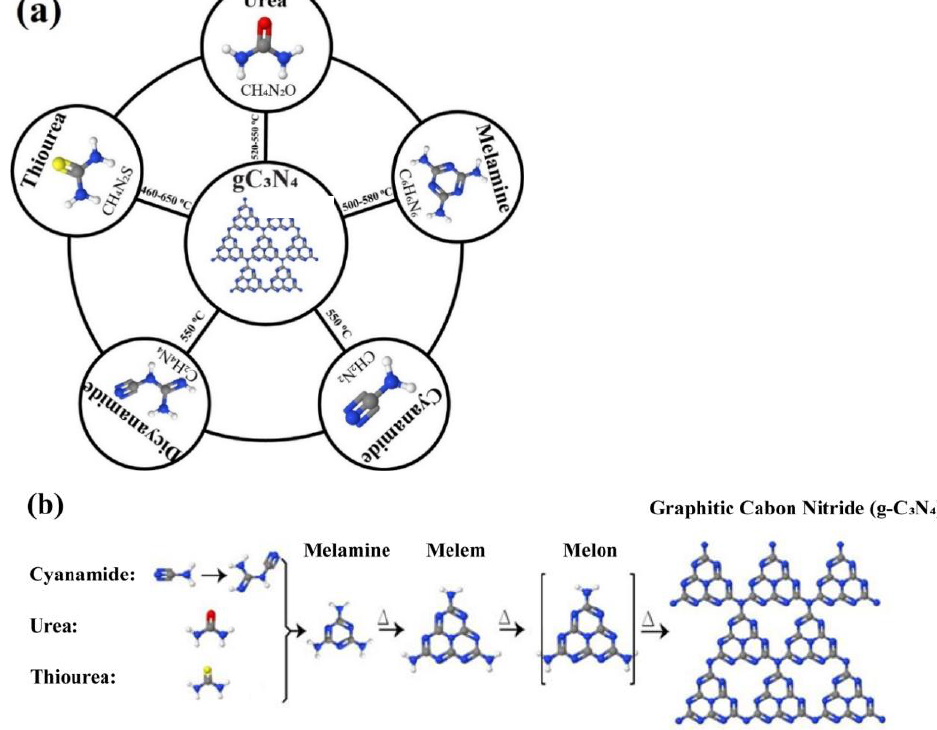
Figure 6. ( a ) Synthesis precursors and calcination temperature for g-C 3 N 4 preparation; ( b ) synthesis procedure using cyanamide (dicyanamide), urea, thiourea, and melamine for g-C 3 N 4 synthesis (gray, blue, red, yellow, and white balls are carbon, nitrogen, oxygen, sulfur, and hydrogen atoms, respectively).